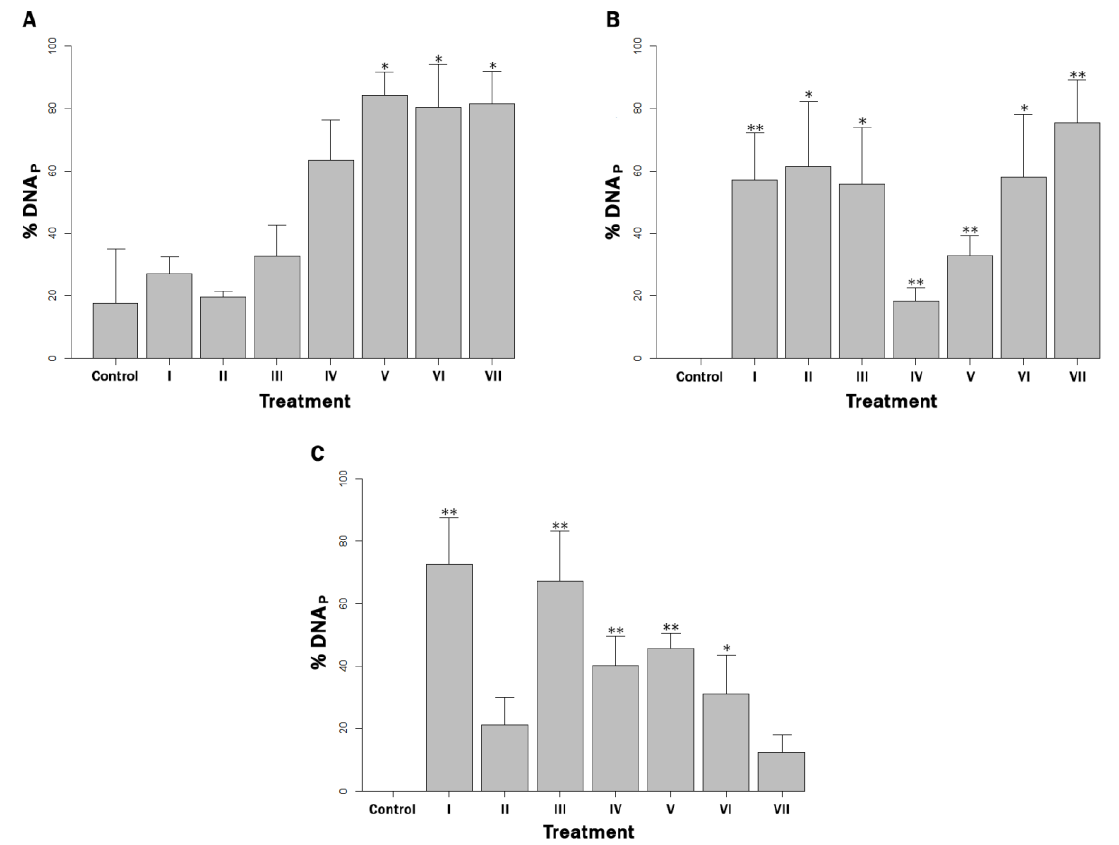
Figure 1. Percentage of DNA protection (% DNA P ) in milk artificially contaminated with: ( A ) 10 2 Figure MAP cells mL −1 , ( B ) 10 4 MAP cells mL −1 and ( C ) 10 6 MAP cells mL −1 , and supplemented with (I) EDTA, (II) BCS, (III) EDTA + BCS, (IV) D-mannitol, (V) gallic acid, (VI) quercetin and (VII) D-mannitol + gallic acid + quercetin, after being challenged with copper ions for 30 min. The de- termination was made by PMS-qPCR. p < 0.05 and p < 0.01 are represented by * and **, respectively.